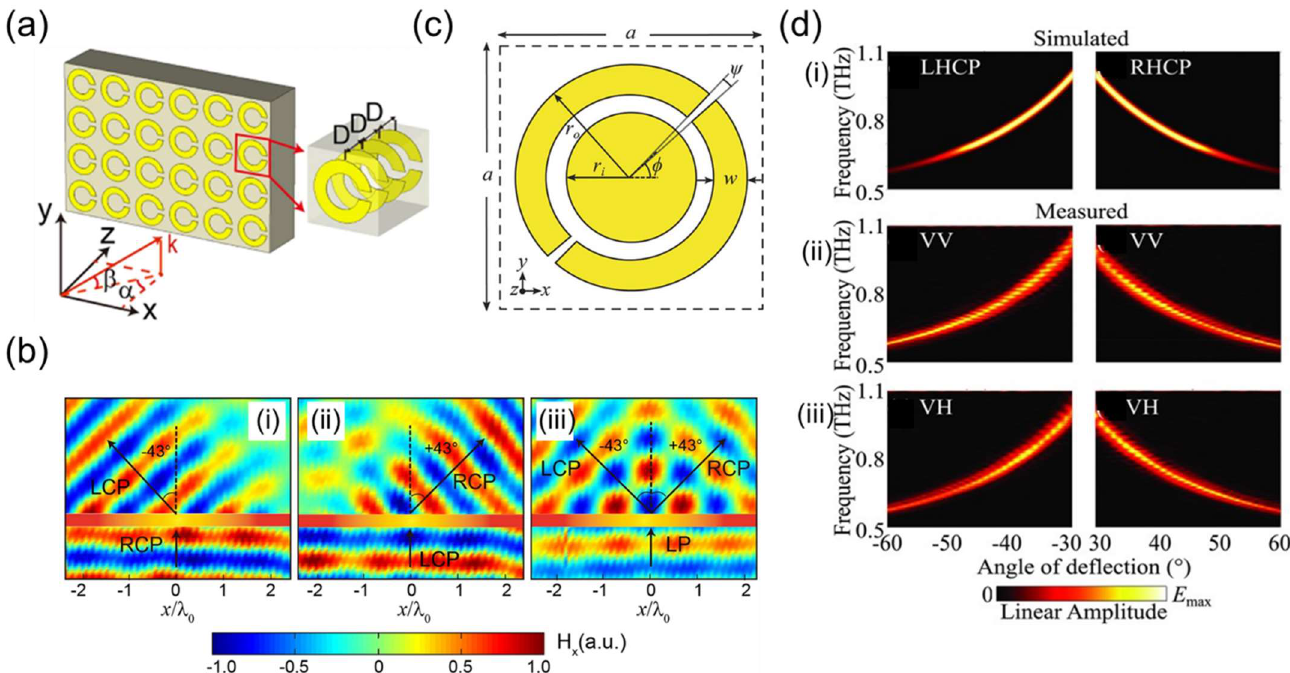
Figure 6. ( a ) Schematic diagram of the four−layer SRR metasurface array [86] . ( b ) The measured distribution of the transmitted magnetic field H x in the x−z plane under normal incidence with RCP ( i ), LCP ( ii ), and LP ( iii ) plane waves [86] . ( c ) Schematic diagram of the metasurface structural unit of the gold disk ring resonator [87] . Copyright 2017 John Wiley and Sons. ( d ) Normalized amplitude spectra from the simulation ( i ) and the measurement. VV ( ii ) and VH ( iii ) denote the input vertical polarization and the corresponding receive polarization, respectively [87] . Copyright 2017 John Wiley and Sons.